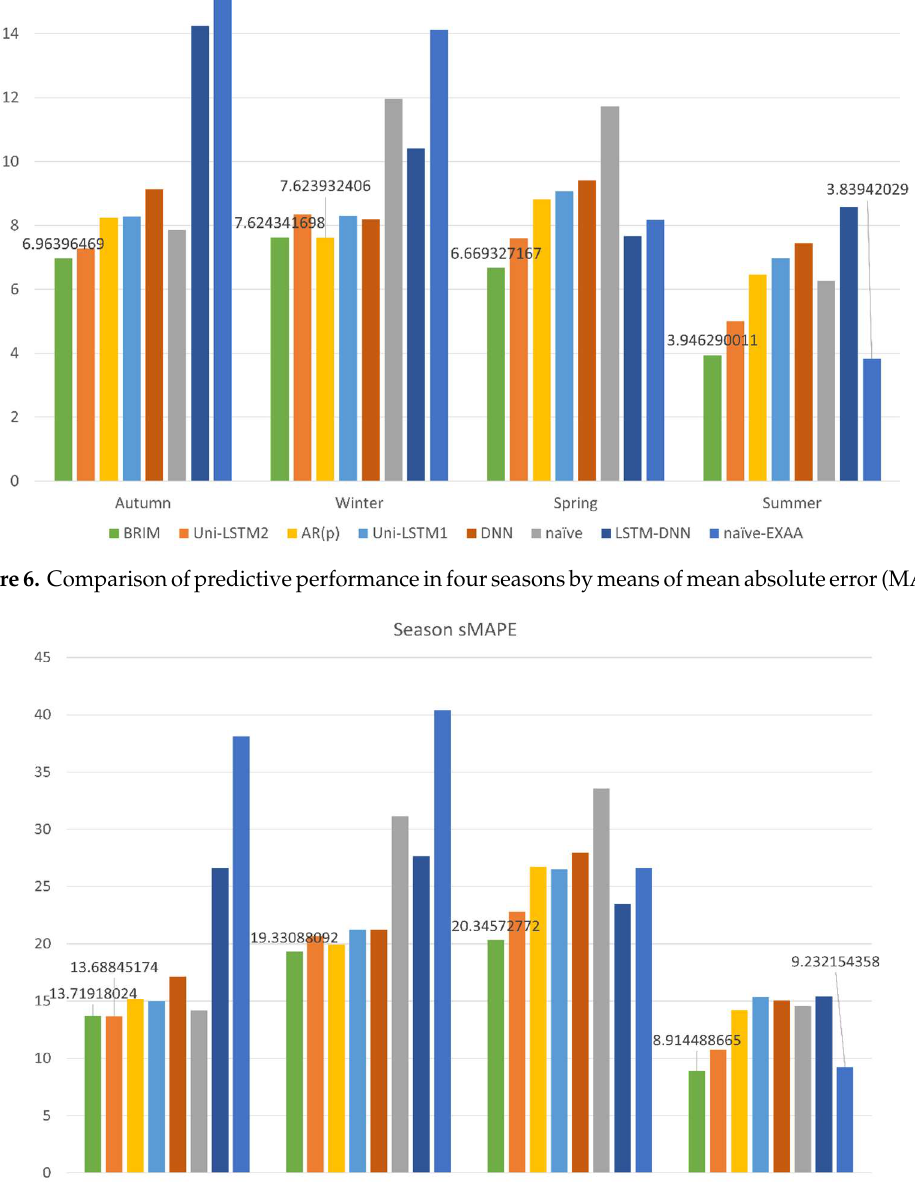
Figure 7. Comparison of predictive performance in four seasons by means of symmetric mean absolute percentage error (sMAPE).